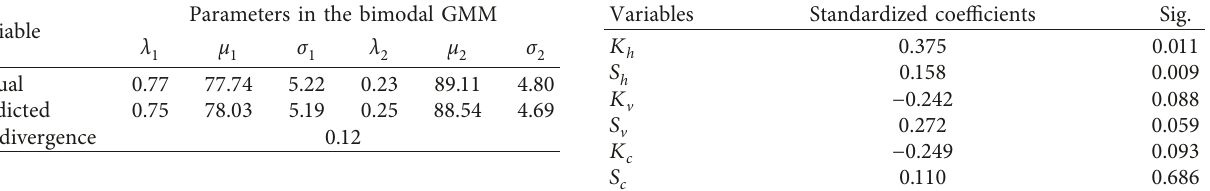
Table 7: Adjusted R 2 of the multiple linear regression models. Predicted parameter